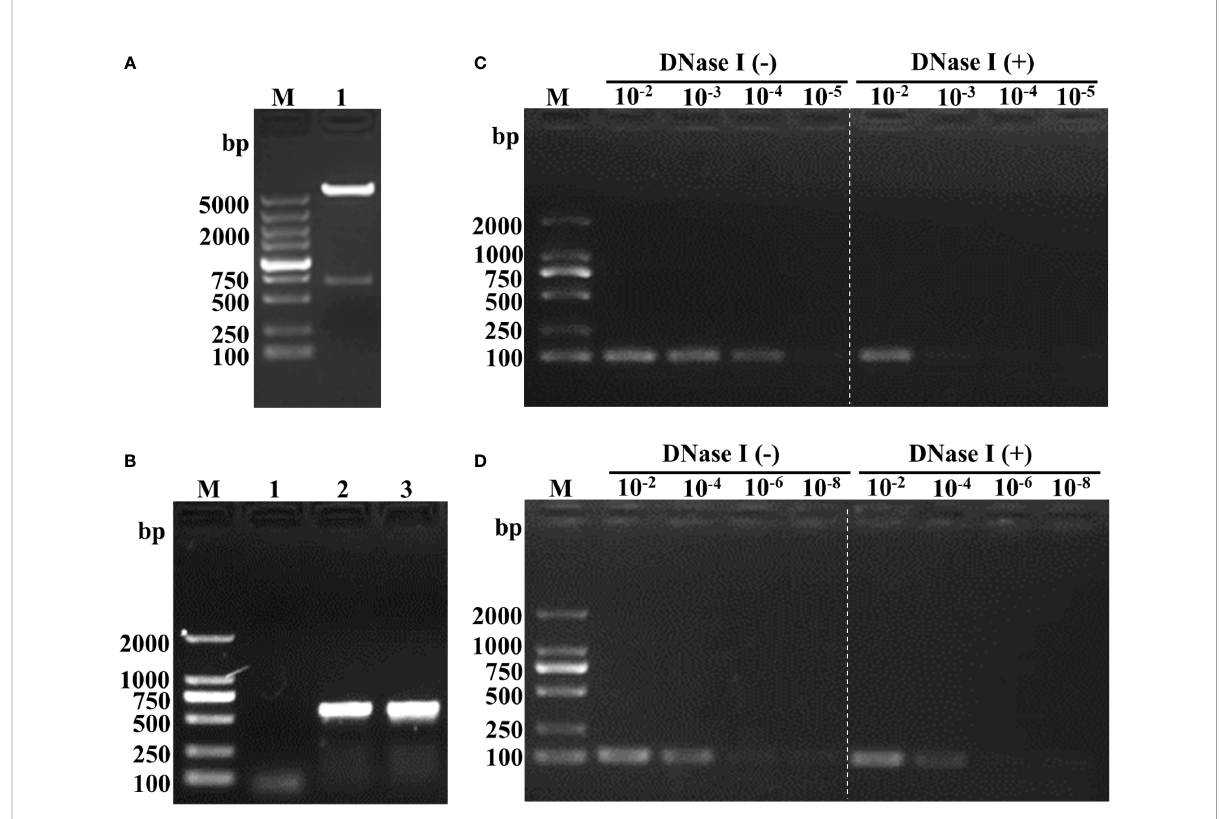
FIGURE 2 Identi fi cation of recombinant plasmid and feasibility analysis of phage encapsulation of the AS-containing plasmid. (A) Double digestion analysis of the recombinant plasmid pEGFP-C1-HA2. Lane M, DL5000 marker; Lane 2, double digestion with Nhe I and Bgl II. (B) Colony PCR identi fi cation of pEGFP-C1-HA2-AS and pEGFP-C1-AS. Lane M, DL2000 marker; Lane 1, blank control; Lane 2, recombinant plasmid pEGFP-C1-HA2-AS; Lane 3, recombinant plasmid pEGFP-C1-AS. (C) DNase I protection assay of T7 phage-encapsulated pEGFP-C1-HA2. Lane M, DL2000 marker; Lane 10 -2 -10 -5 (Left of white dotted line), T7-WT/pEGFP-C1-HA2 samples without enzyme digestion; Lane 10 -2 -10 -5 (Right of white dotted line), T7-WT/ pEGFP-C1-HA2 samples digested by enzyme. (D) DNase I protection assay of T7 phage-encapsulated pEGFP-C1-HA2-AS. Lane M, DL2000 marker; Lane 10 -2 -10 -5 (Left of white dotted line), T7-WT/pEGFP-C1-HA2-AS samples without enzyme digestion; Lane 10 -2 -10 -5 (Right of white dotted line), T7-WT/pEGFP-C1-HA2-AS samples digested by enzyme. Compared (C) to (D) , plasmid with AS insertion could be encapsulated by T7 phage and protected against enzyme digestion, so that HA2 gene was detected by PCR as showed in the right of white dotted line in (D)